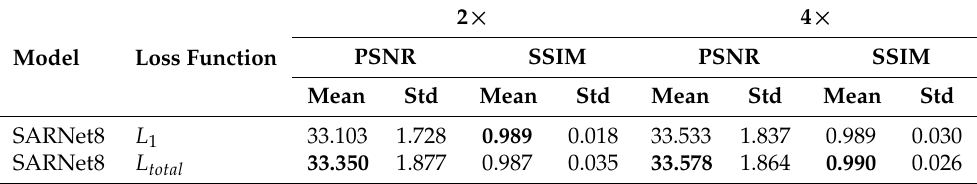
Table 3. PSNR and SSIM metrics obtained for the test set with different loss functions.